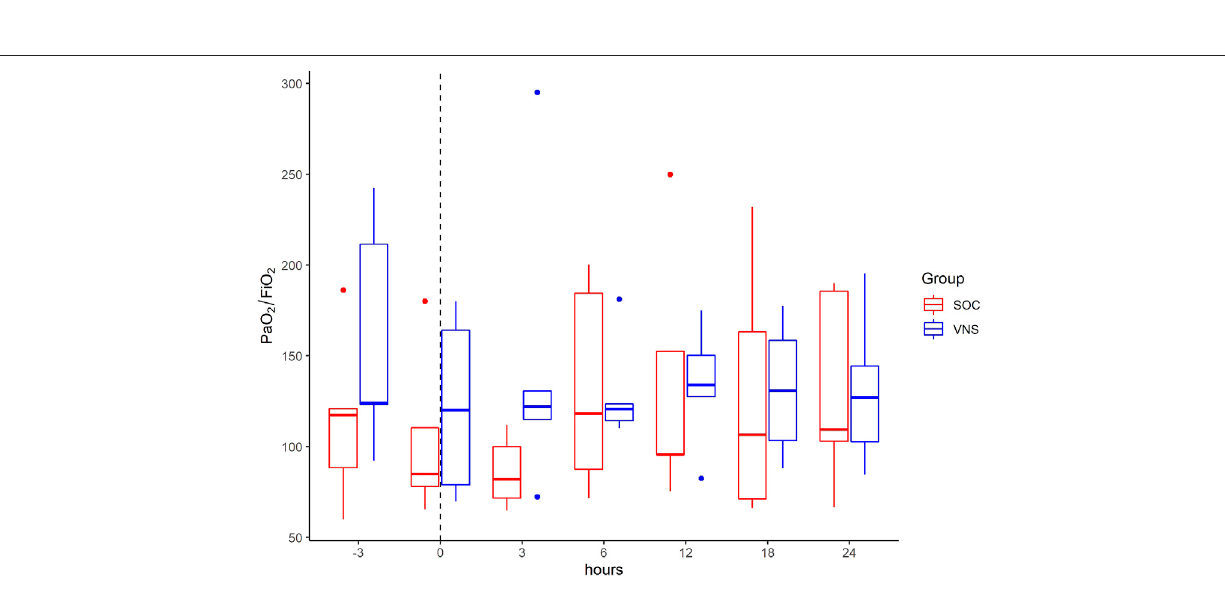
Frontiers in Physiology |